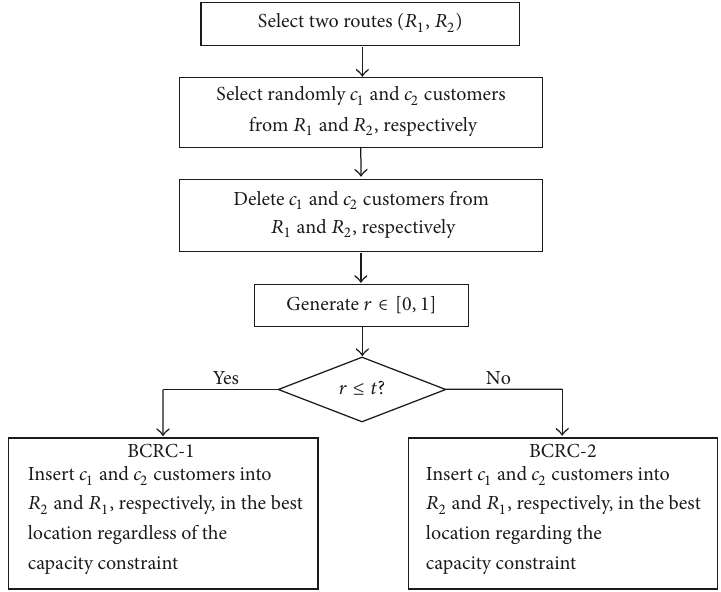
Figure 4: The modified BCRC.